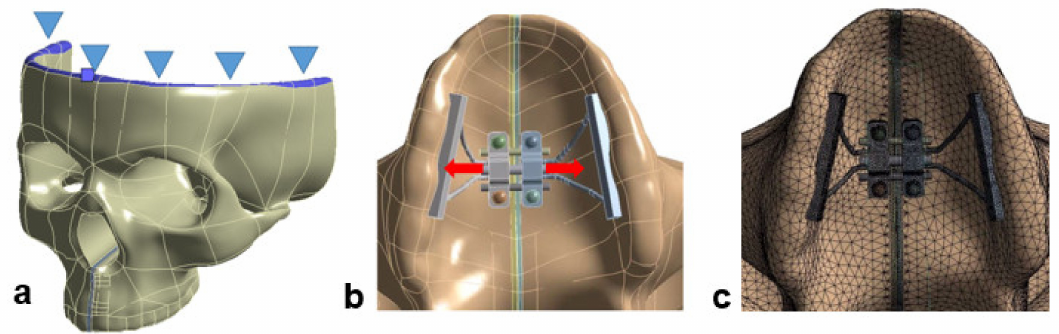
Figure 4. ( a ) The cross-section of cranium was constrained as boundary condition (triangle arrow- heads); ( b ) palatal bone-borne force application was indicated with red arrows; 0.25 mm displacement